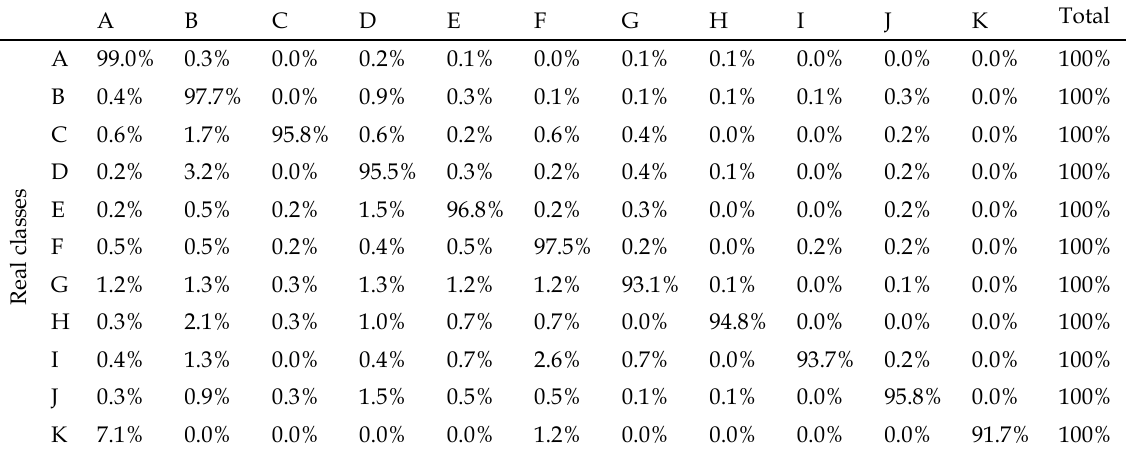
Table 4. Confusion matrix (predicted and real values by activity types) of RF model Predicted